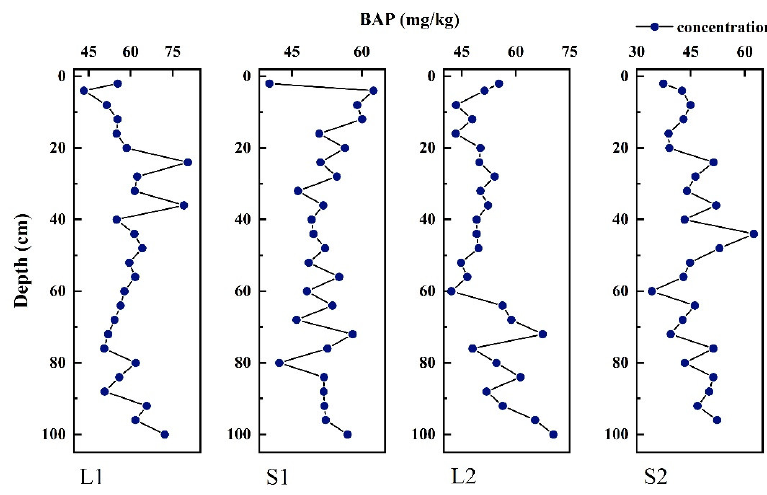
Figure 4. The vertical variations of BAP fractions (Ex-P, Fe-P, and OP) along the sediment cores.